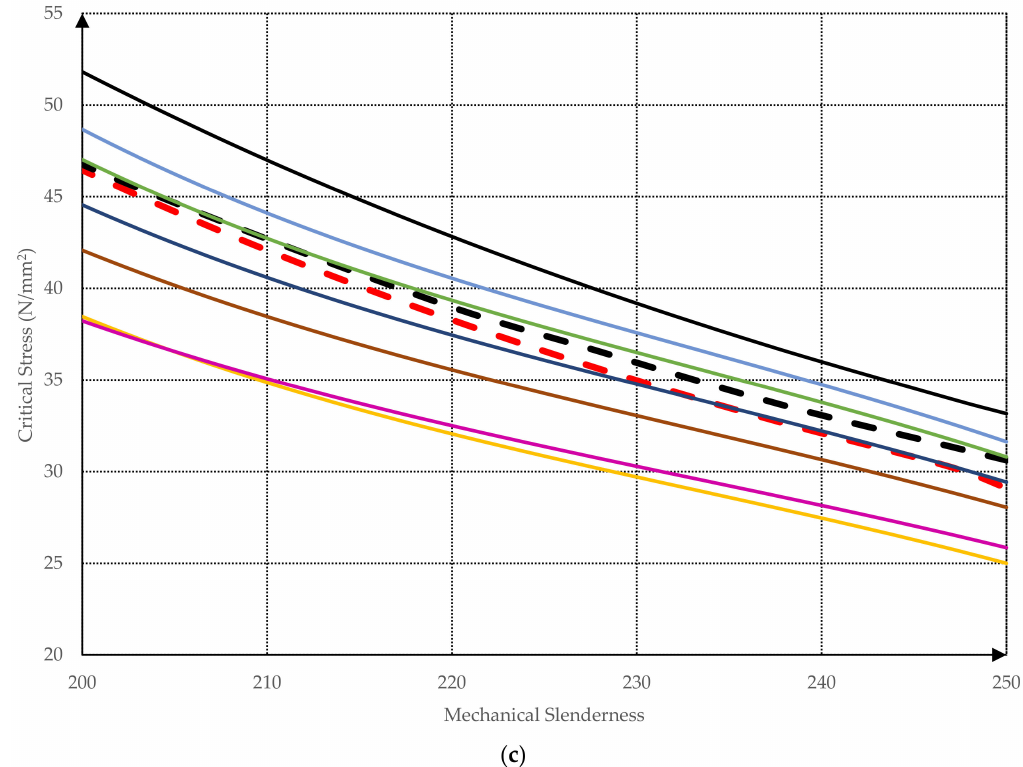
Figure 10. Strength–mechanical slenderness graph. Comparison design standard models and numerical simulation: ( a ) mechanical slenderness from 0 to 250; ( b ) detail for slenderness ratios from 125 to 250; ( c ) detail for slenderness ratios from 200 to